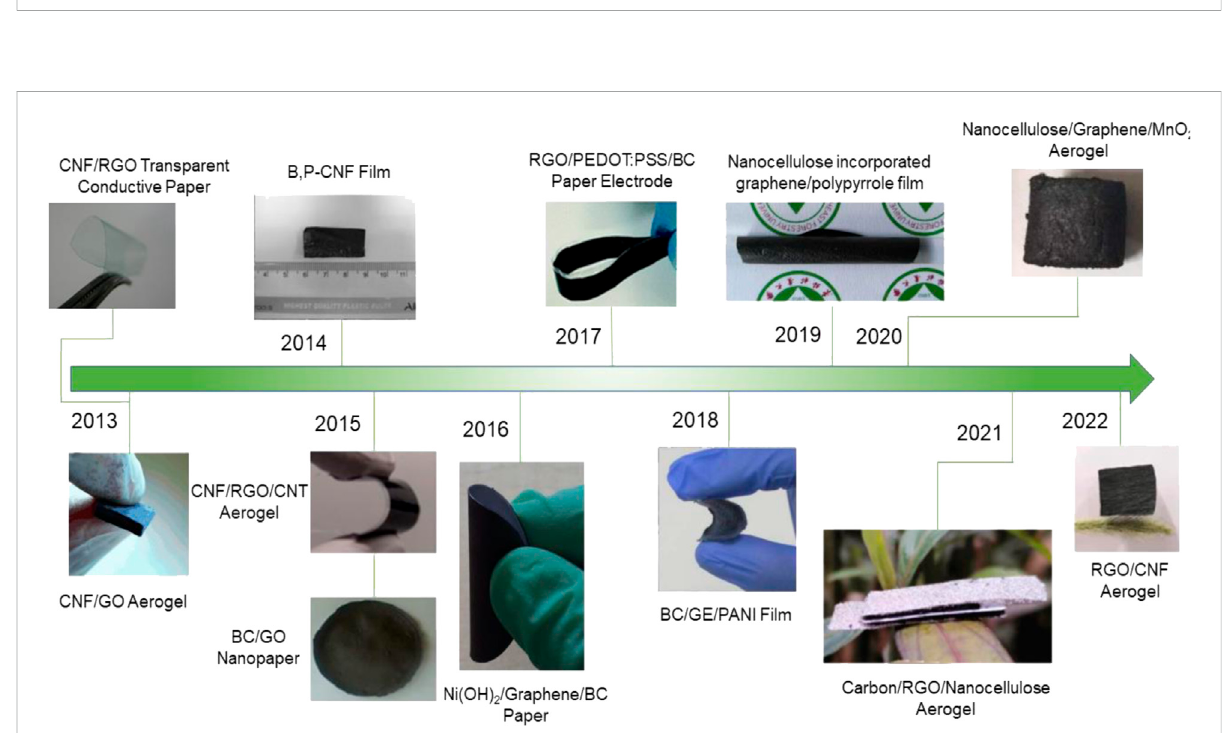
FIGURE 4 Brief timeline of nanocellulose/graphene composites for supercapacitors. Reproduced from: Gao et al. (2013b), Elsevier. Hamedi et al. (2013), Wiley-VCH; Chen et al. (2014), Wiley-VCH; Zheng et al. (2015), American Chemical Society; Liu et al. (2015), Royal Society of Chemistry. Ma et al. (2016a), Elsevier. Zhao et al. (2017), American Chemical Society; Luo et al. (2018), Elsevier. Hou et al. (2019), Elsevier. Wang et al. (2020b), Springer; Chen et al. (2021b), Elsevier; Liu et al. (2022c),